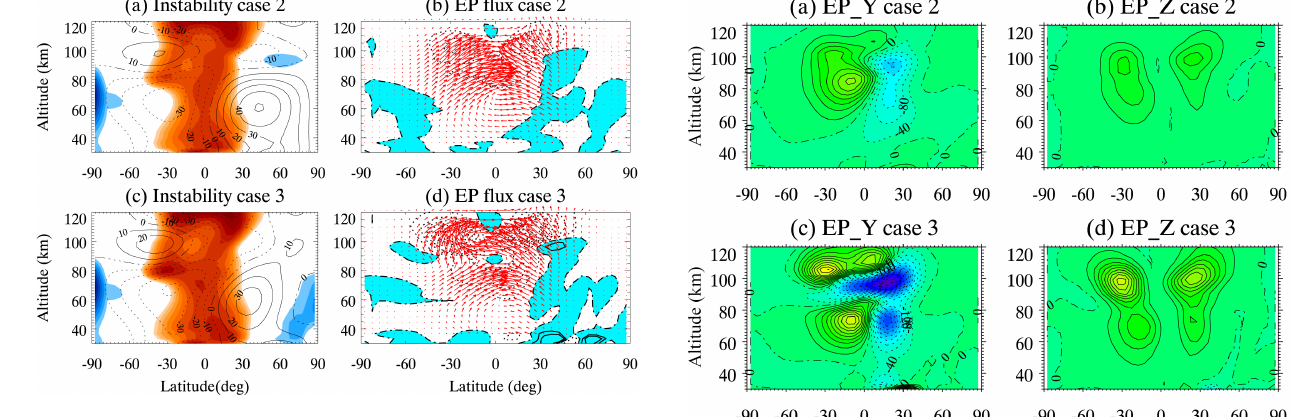
Figure 11. The same as Fig. 7 but for the W2 during model days 15–20 for (a, b) case 2 and (c, d) case 3.